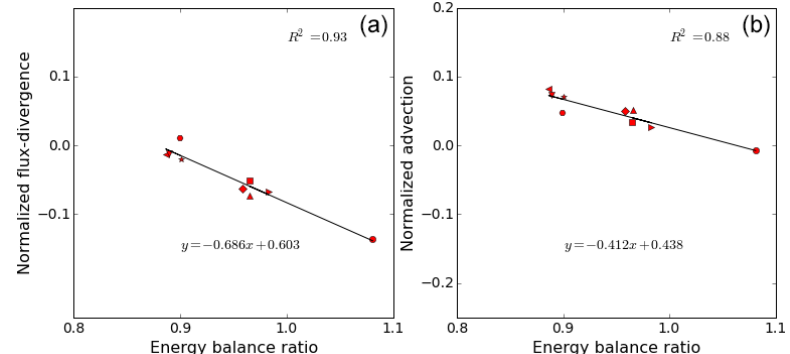
Figure 7. Correlation between flux-divergence and EBR for hectometer scale heterogeneity (a) ; correlation between advection and EBR for hectometer scale heterogeneity (b)